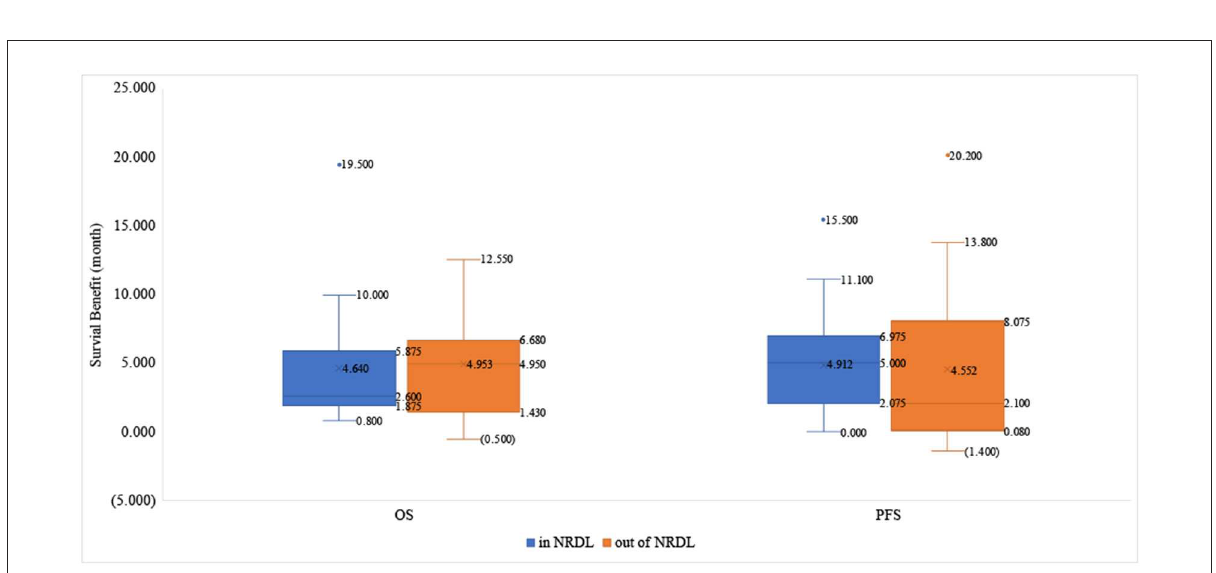
FIGURE3 The survival benefit in OS and PFS of drugs in and out of